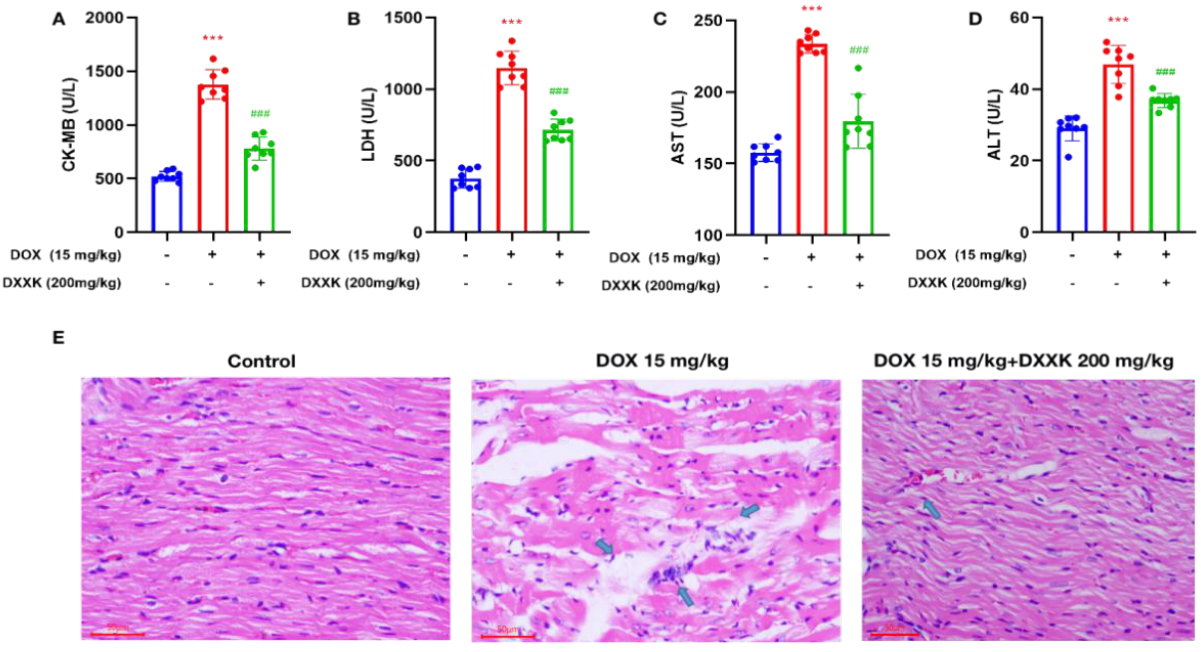
Figure 1. DXXK protects against heart injury caused by DOX. ( A ) CK-MB; ( B ) LDH; ( C ) ALT; ( D ) AST; ( E ) Representative photomicrographs for HE staining of heart histological changes. Cell vacuoles, hydropic degenerations and inflammatory cell infiltration areas are indicated by arrows. *** p < 0.001 compared with the control group. ### p < 0.001 compared with the DOX group.”+”indicates that drugs are added, and “-” indicates that drugs are not added.